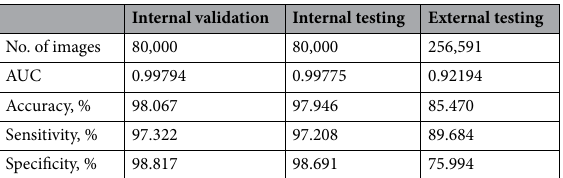
Internal validation Internal testing External